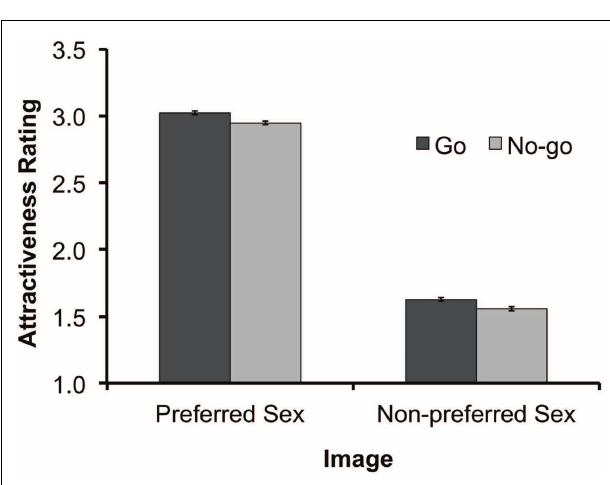
FIGURE 1 | Example of the stimulus sequence in the Go/No-go task of Experiment 1. In this example, attractive male images are “Go” stimuli that require a speeded key-press response, and attractive female images are